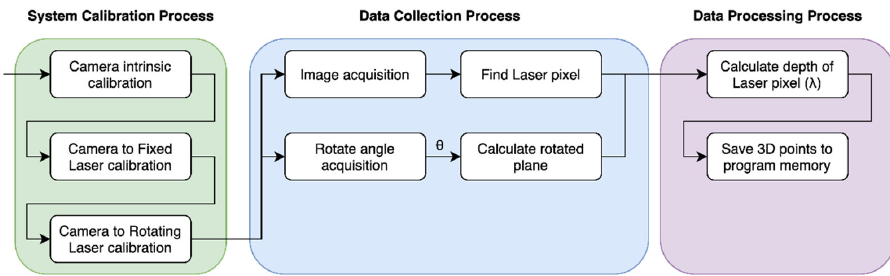
Figure 3. Flowchart of our scanning process.